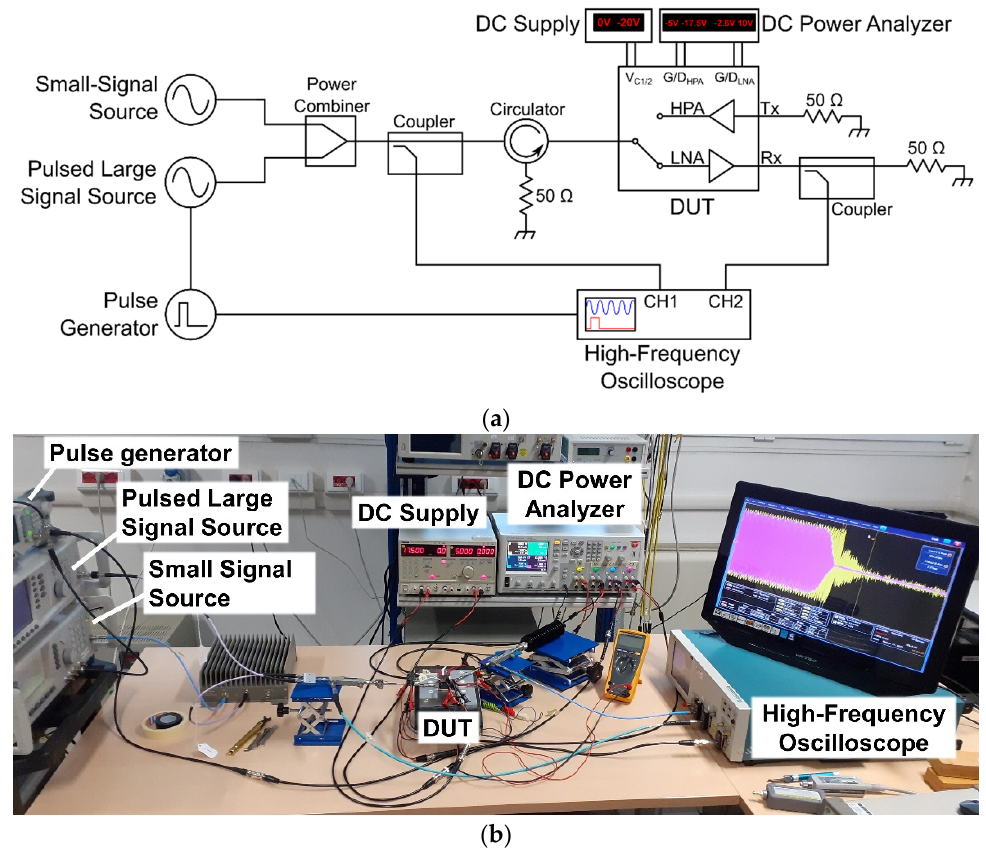
Figure 6. Test setup for the characterization of the Rx recovery time. ( a ) Block diagram; ( b ) imple- mented setup.